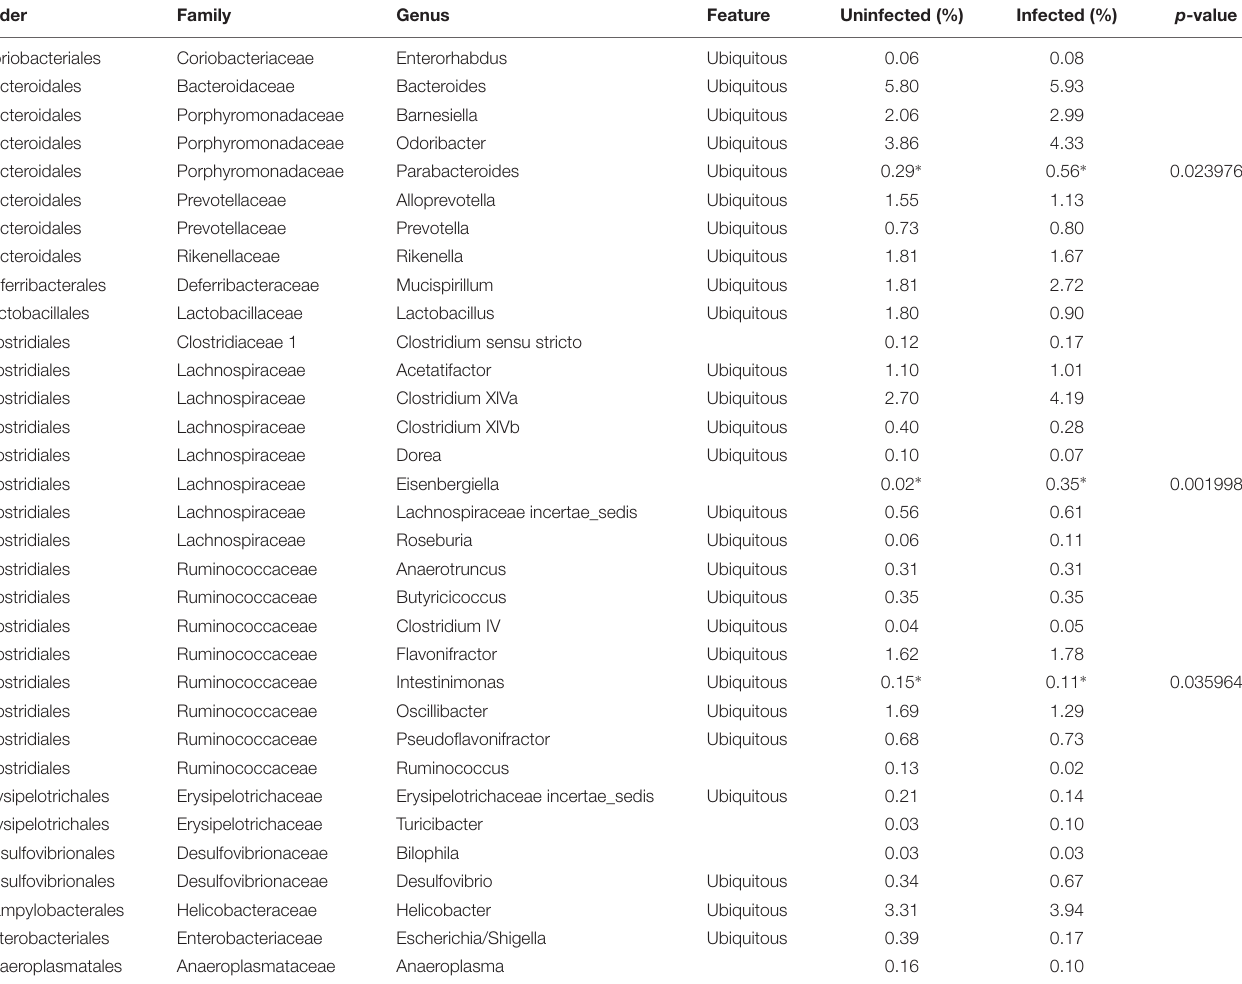
TABLE 4 | The abundance of genera ( > 0.1%) in the gut microbiomes of E. granulosus infected mice and uninfected mice determined by LEfSe